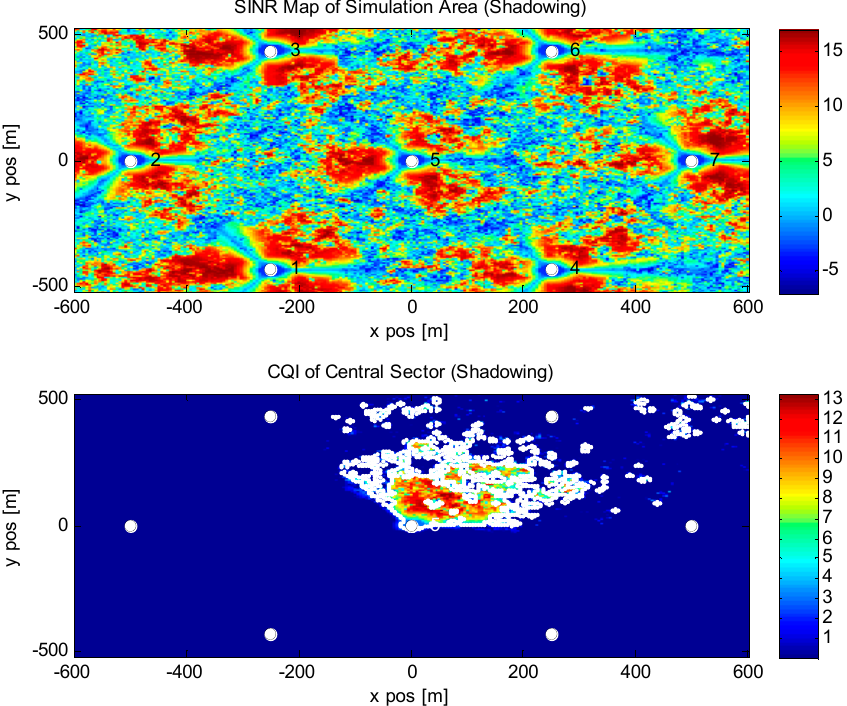
Figure 5. SINR map with shadowing of our simulated area. Shadow fading is considered in this figure, buildings, trees and other loose impediments will affect the radius of the wireless signal.